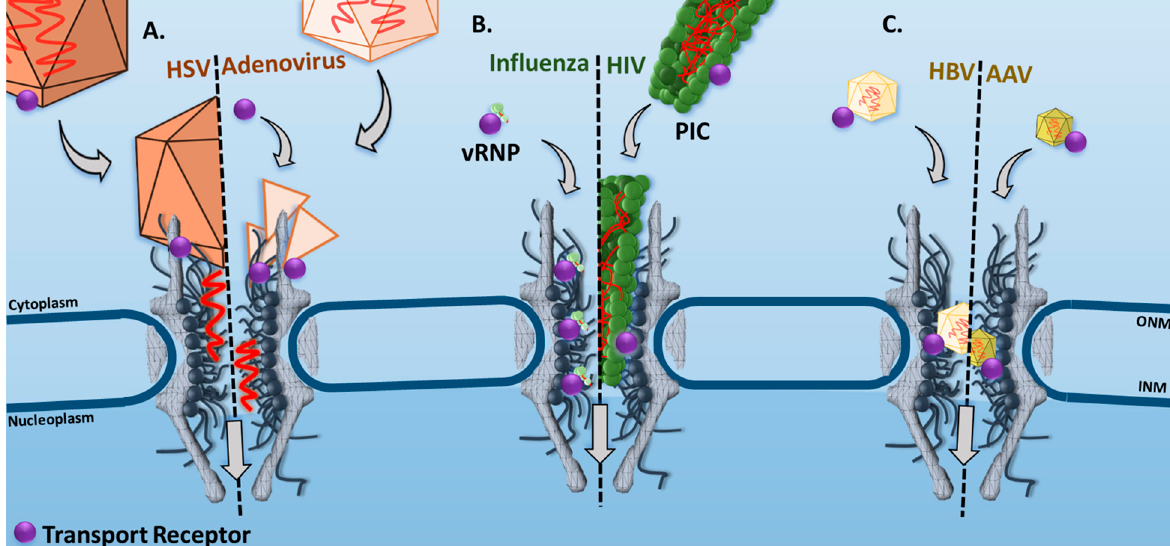
Figure 1. Involvement of transport receptors in viral genome translocation through the nuclear pore complex (NPC). ( A ) Herpes simplex virus (HSV) and adenovirus capsid dock to an NPC through interacting with cytoplasmic nucleoporins (Nups) and then inject viral genome into the nucleus. ( B ) Facilitated transport of influenza’s viral ribonucleoprotein (vRNP) and human immunodeficiency virus’s (HIV’s) pre-integration complex (PIC) through the NPC. ( C ) Facilitated transport of hepatitis B virus (HBV) core protein and adeno-associated virus (AAV) capsid into the nucleus. The viral particles—HSV-1 [15], adenovirus 2 [20], Influenza A vRNP [22], HIV-1 PIC [23], HBV viral core [24], and AAV2 [25]—have been scaled to the NPC dimensions [9]. The transport receptors and the distance between NPCs are not to scale. ONM and INM indicate the outer nuclear membrane and inner nuclear membrane, respectively.